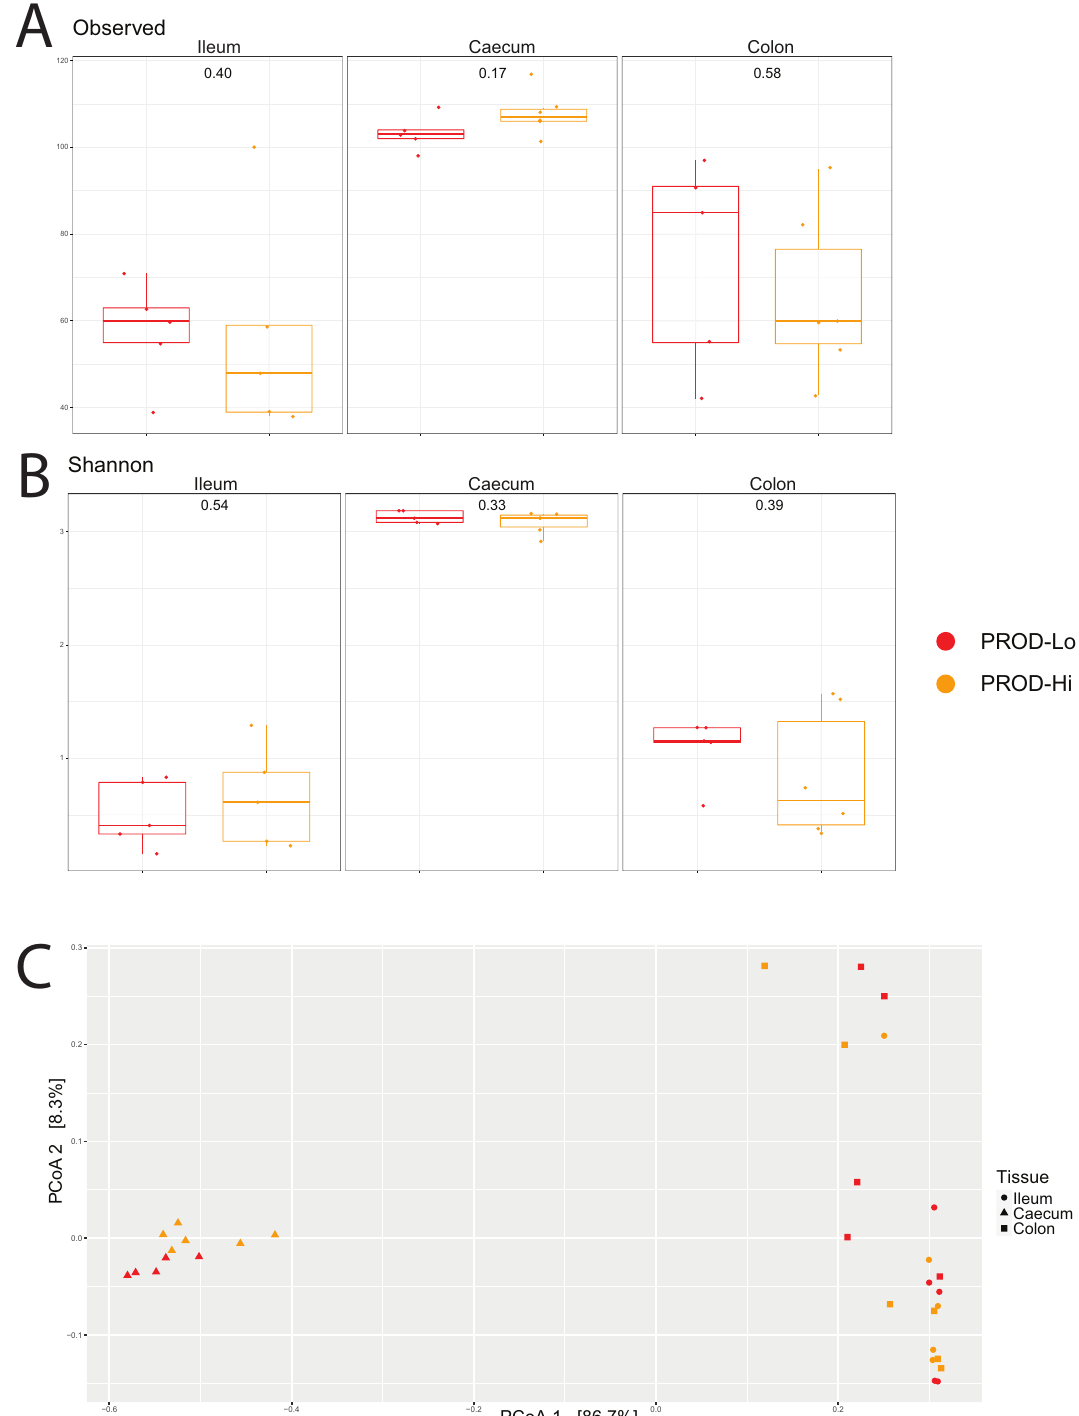
Figure 2. This is a wide figure. Figure 5. Microbiota results of various intestinal segments from the high and low production groups. ( A ) shows the microbiota diversity, observed species, for the tissues, whereas ( B ) shows the Shannon index. ( C ) shows the microbiota composition for the ileum (circles), caecum (triangles), and colon (squares), in principal coordinate analysis (PCoA) plots. Red represents the low-production (PROD-Lo) samples, whereas orange represents the high-production (PROD-Hi)